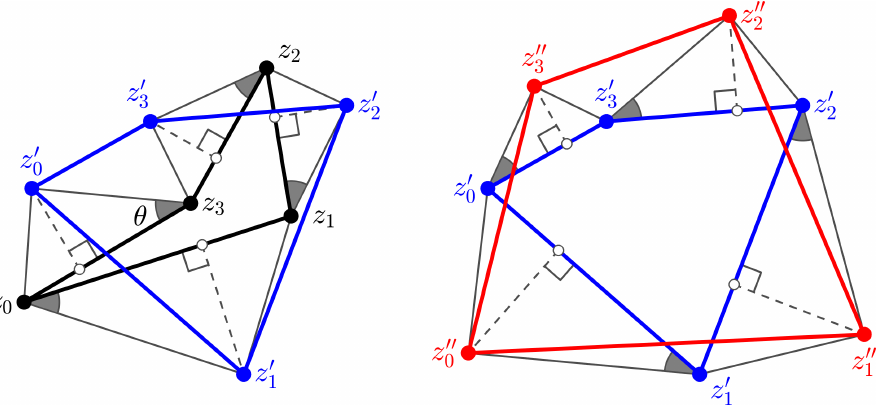
Figure 2. Transformation of an initial polygon by two substeps based on similar